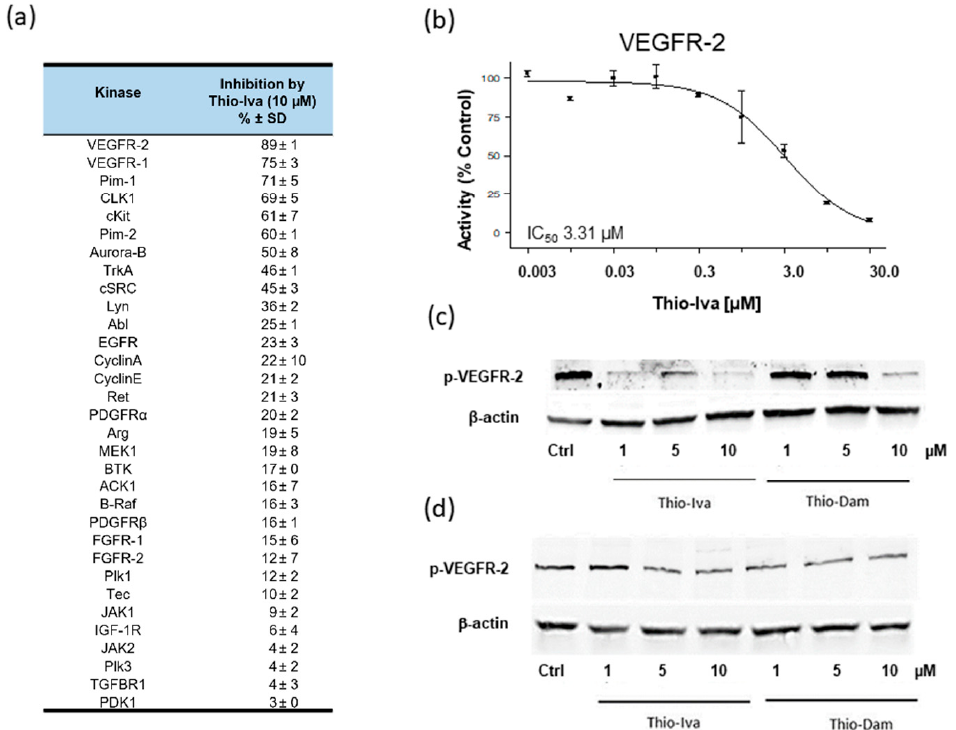
Figure 2. VEGFR-2 inhibition by novel compounds. Enzymatic kinase profiling on 32 kinases revealed multi-kinase inhibition of Thio-Iva, with the most pronounced effects on VEGFR-2 kinase ( a ). Dose–response curve for Thio-Iva-induced VEGFR-2 kinase inhibition ( b ). Data are given as means ± SD of n = 2–3 independent determinations per kinase. Western blot of Thio-Iva and Thio-Dam-induced inhibition of VEGFR-2 phosphorylation in Huh-7 ( c ) and SNU-449 ( d ) cells after 24 h of incubation, confirming the VEGFR-2 inhibiting effects of both compounds on the cellular level.